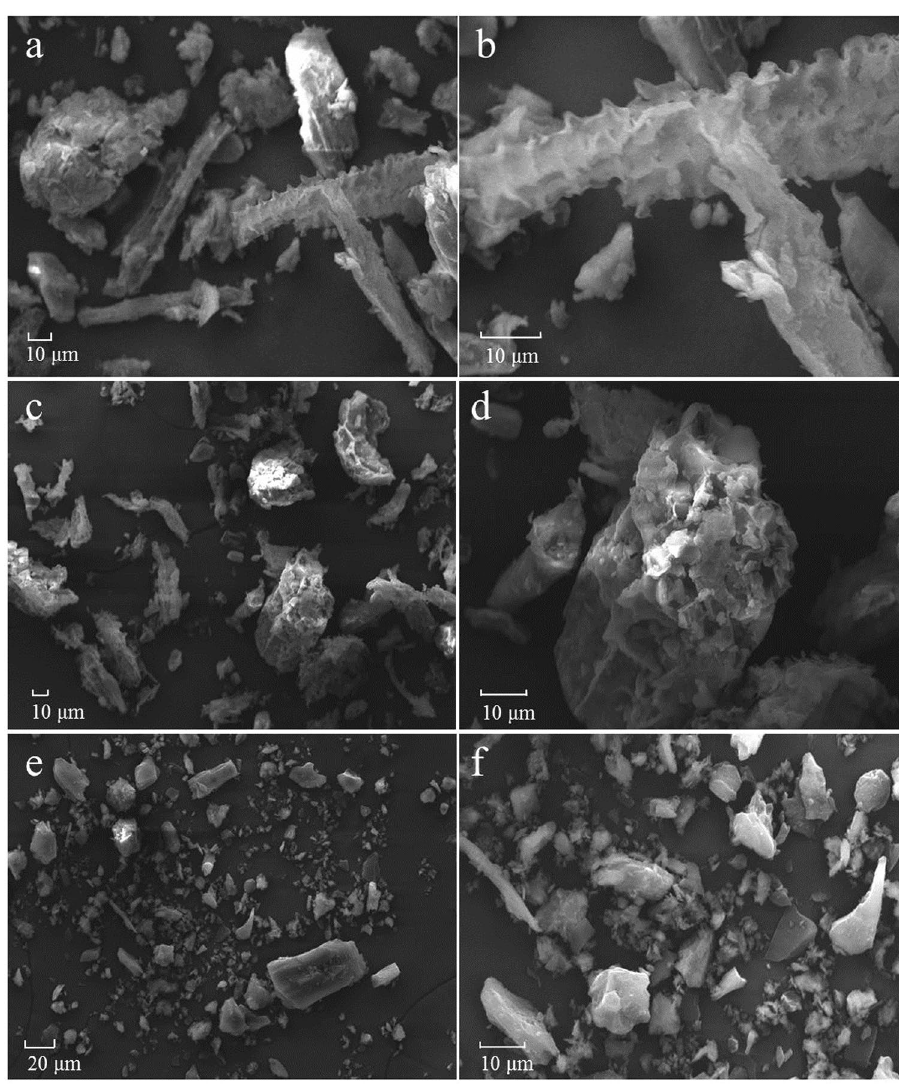
Figure 4. Scanning electron micrograph spectra of the biochar produced from cattle manure [CM100 ( a , b ) and CM400 ( c , d )], Bamboo biochar [BB600 ( e , f )]. The numbers in the sample names represent the pyrolysis temperatures.